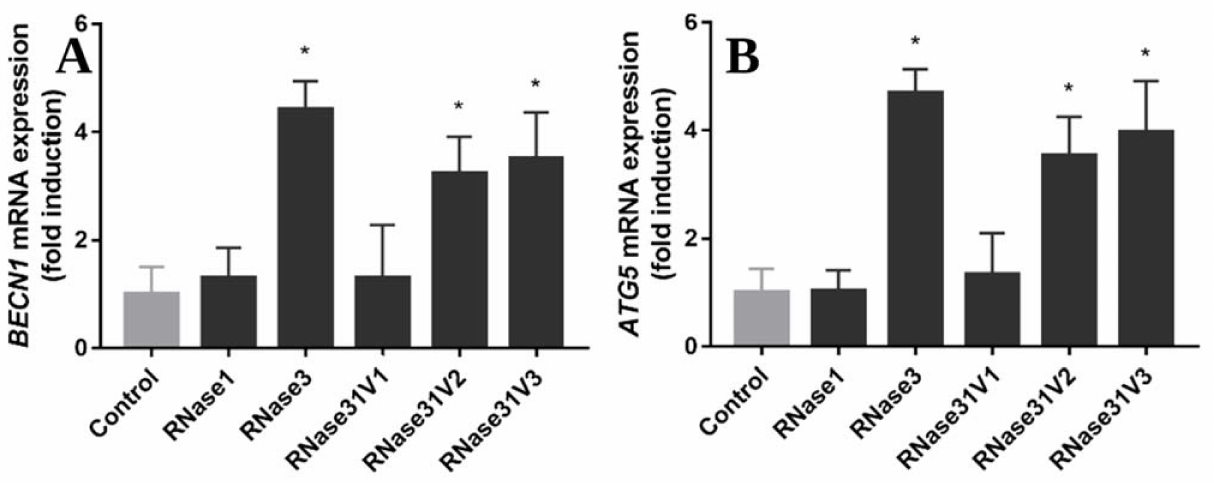
Figure 6. RAW 264.7 macrophages were infected with M. aurum and treated by 10 µ M of proteins (RNase 1, 3 and 3/1 v1-3) for 24 h. Real-time qPCR measured the relative expression of BECN1 ( A ) and ATG5 ( B ) genes, normalized by housekeeping gene β -actin . Results are shown from three independent experiments (mean ± SD). * indicates significant difference compared with control group ( p <